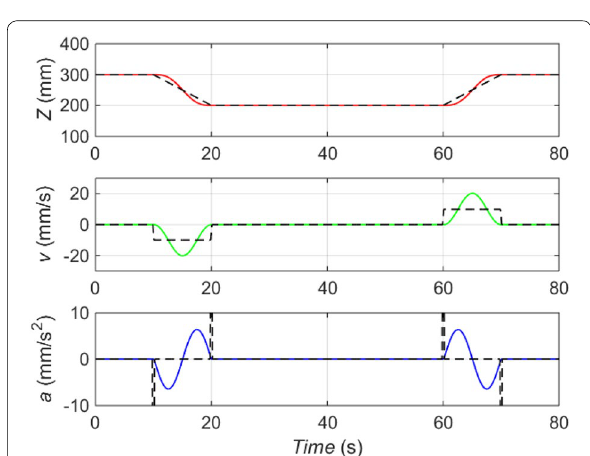
Figure 10 Position, velocity, and acceleration curves of cycloid trajectory planning in the Z